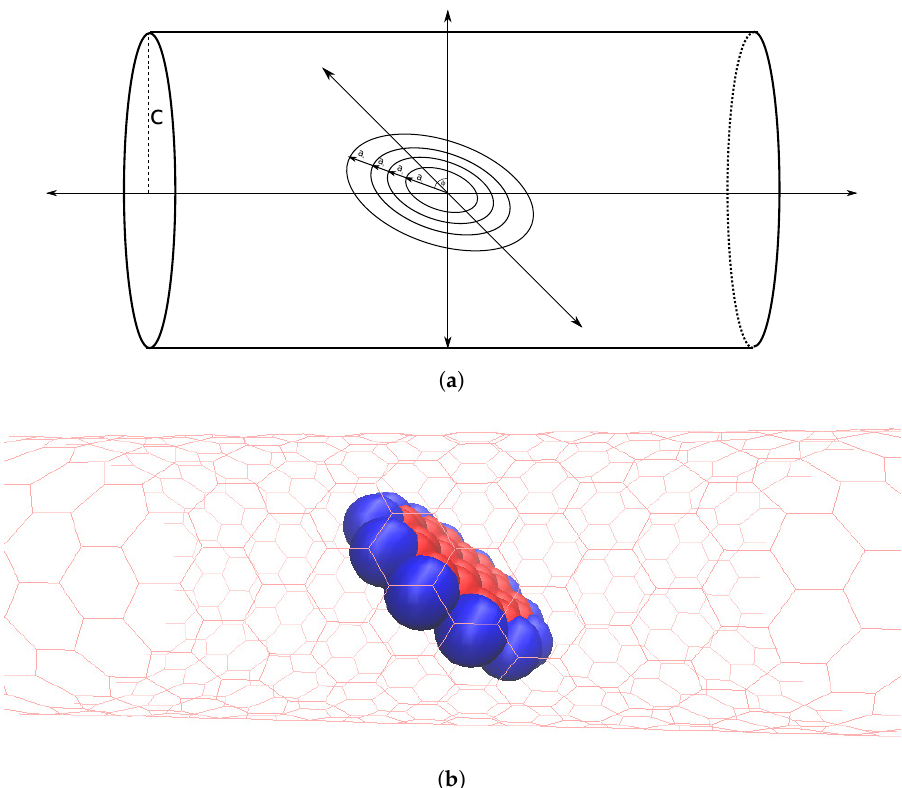
Figure 5. Coronene molecule within tube ( a ) approximated by four concentric rings; centered on tube’s central axis and tilted by an angle φ and ( b ) represented by space filling